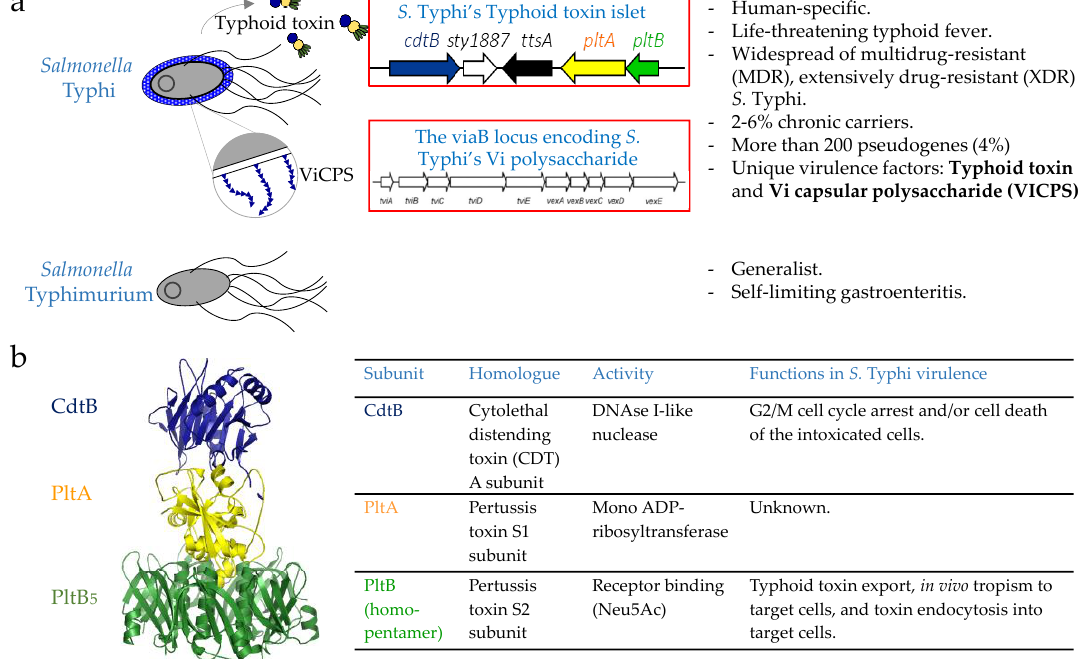
Figure 3. A summary of notable difference between typhoidal Salmonella and nontyphoidal Salmonella (NTS). ( a ) Different from S. Typhimurium, S. Typhi is human-specific and causes a life-threatening disease, typhoid fever. ( b ) Structure and function of typhoid toxin.